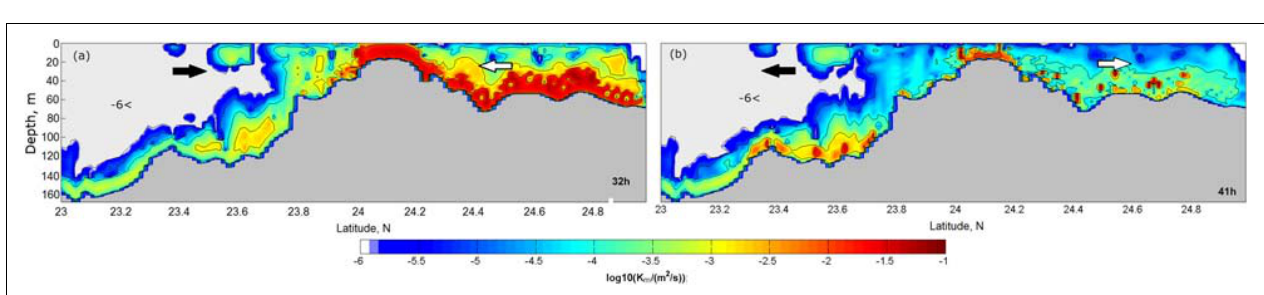
FIGURE 7 | Tidal currents at a depth of 90 m below the surface at (A) 11:00 (at max flood elevation), (B) 14:00 (flow reversal from flood to ebb), and (C) 17:00 (at min ebb water level) on June 27, 2013.